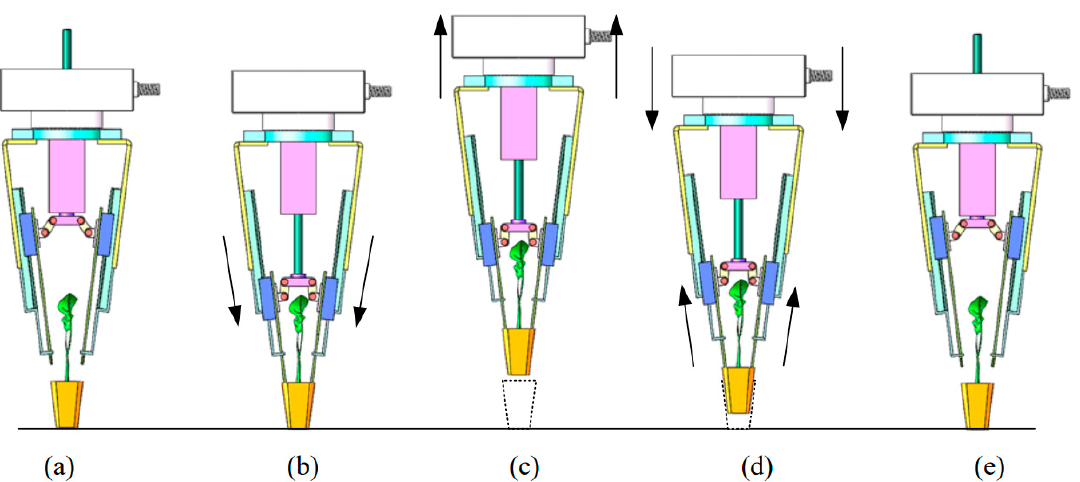
Figure 5. The transplanting process of the end effector. ( a ) Initial state; ( b ) the seedling is clawed out; ( c ) the end effector is raised; ( d ) the end effector and claw are contracted; ( e ) replenishment is